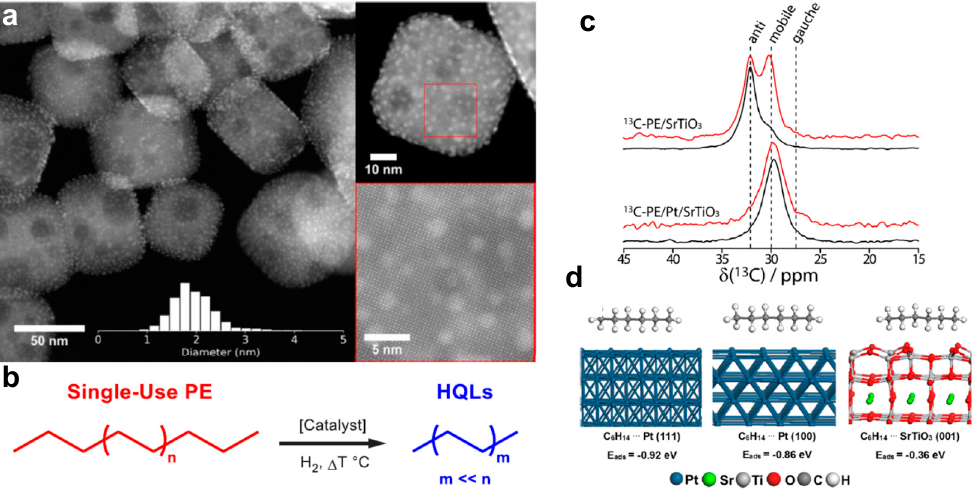
Figure 3. ( a ) Electron micrographs of Pt nanoparticles with an average size of 2.0 ± 0.5 nm on SrTiO 3 support. ( b ) Hydrogenolysis of polyethylene into high-quality liquid products. ( c ) 13 C MAS (red) and CPMAS (black) spectra of 13 C-enriched polyethylene adsorbed on a SrTiO 3 support (top) and a Pt–SrTiO 3 catalyst (bottom). ( d ) Side view of optimized structures of n-hexane on Pt(111), Pt(100), and TiO 2 double-layer-terminated SrTiO 3 (001) surface models